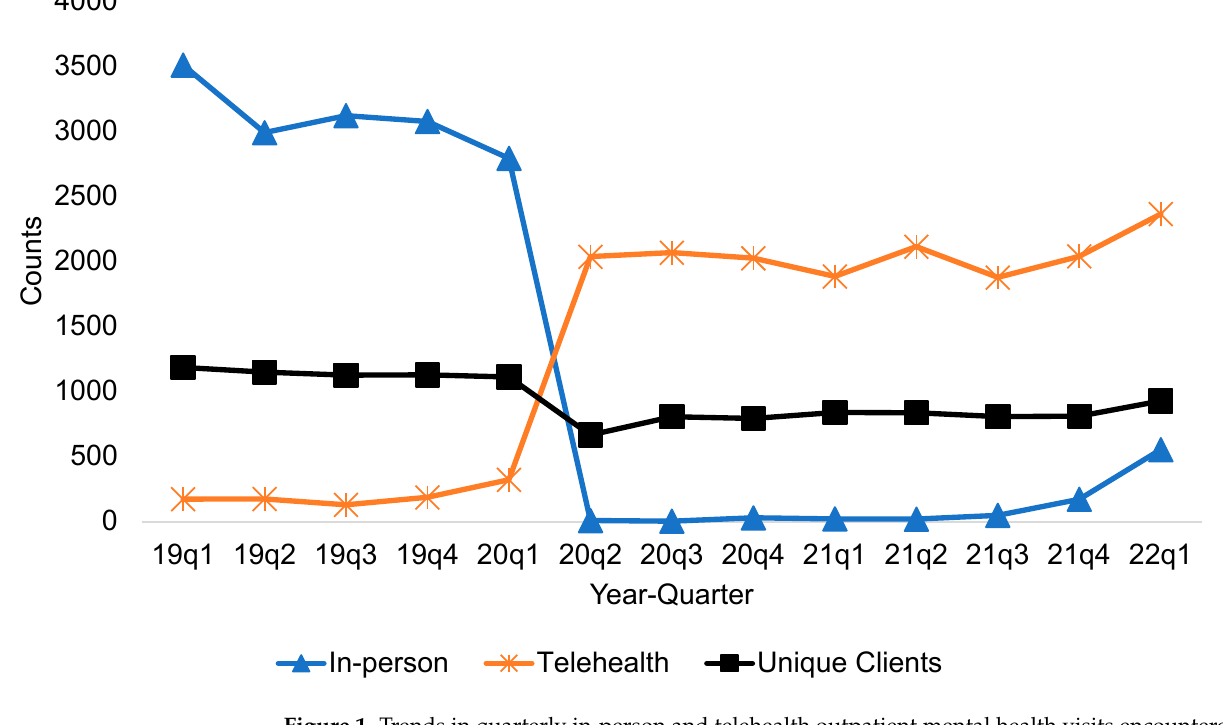
Figure 1. Trends in quarterly in-person and telehealth outpatient mental health visits encountered in Northeast Delta Human Services Authority (NEDHSA) behavioral health clinics before and during the COVID-19 pandemic. Note: 19q1 represents 2019 quarter 1 (2019 January to March). Table 2. Characteristics of the sample (N = 1115). Variable Number (N) Proportion (S.D.) Number of visits (mean,